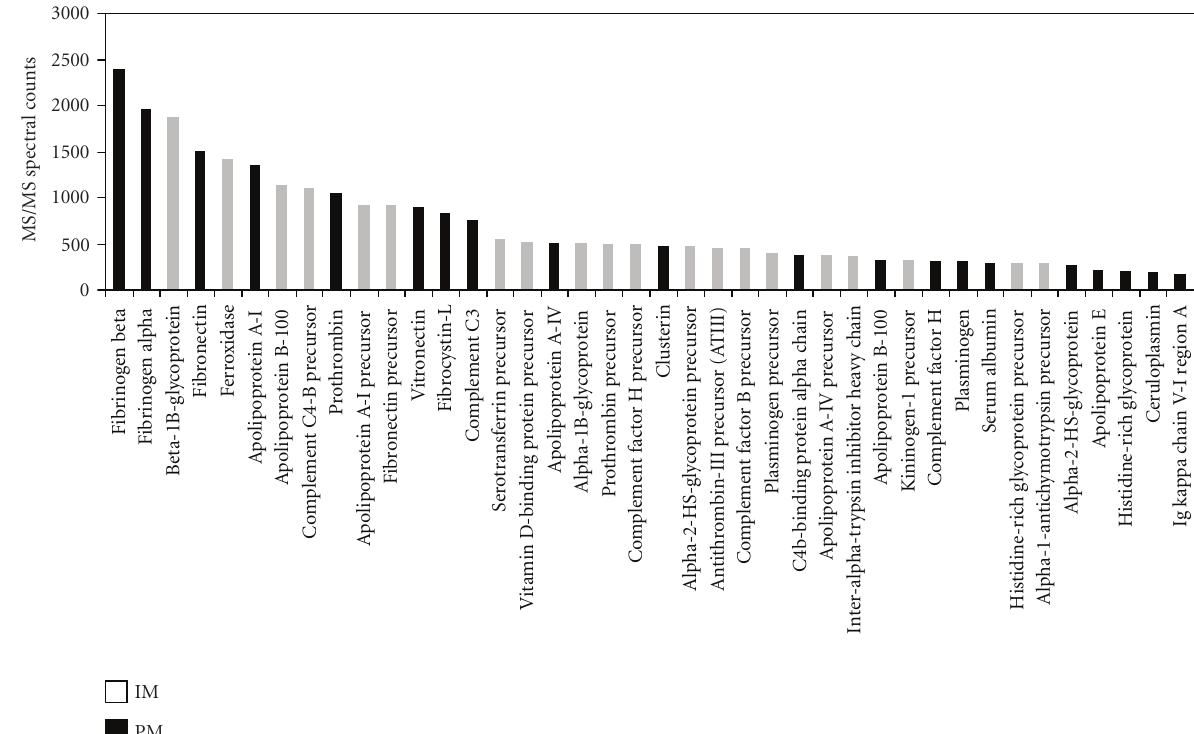
Figure 5: Relative abundance of the twenty most abundant proteins determined by counting the number of MS/MS spectra for each protein identified after immunoa ffi nity depletion (IM) or Hexapeptide ligand library treatment (PM) of plasma.